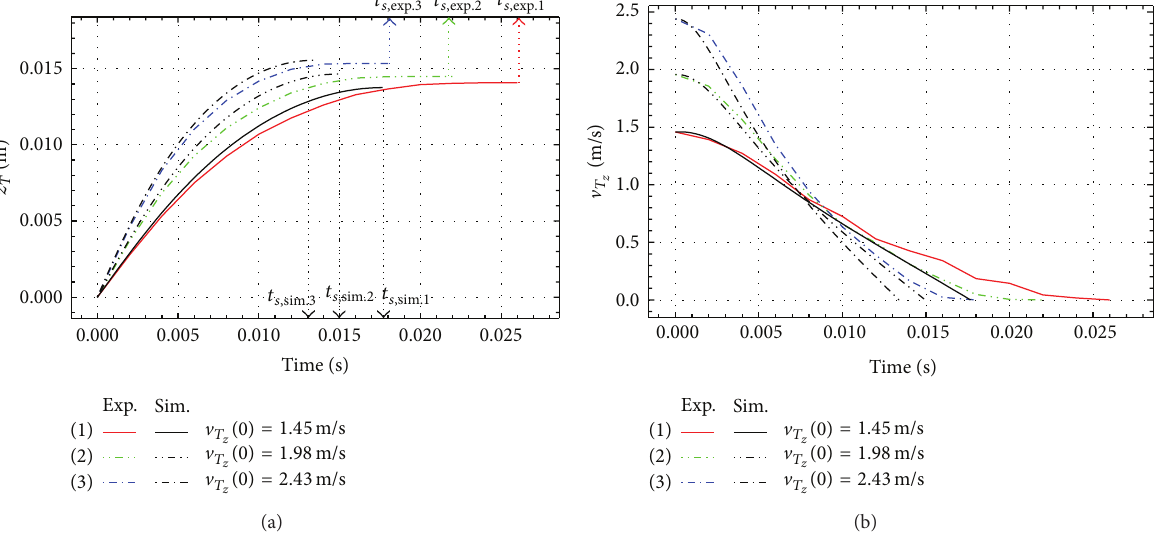
Figure 8: Experimental and simulation results for 𝑞(0) = 55 ∘